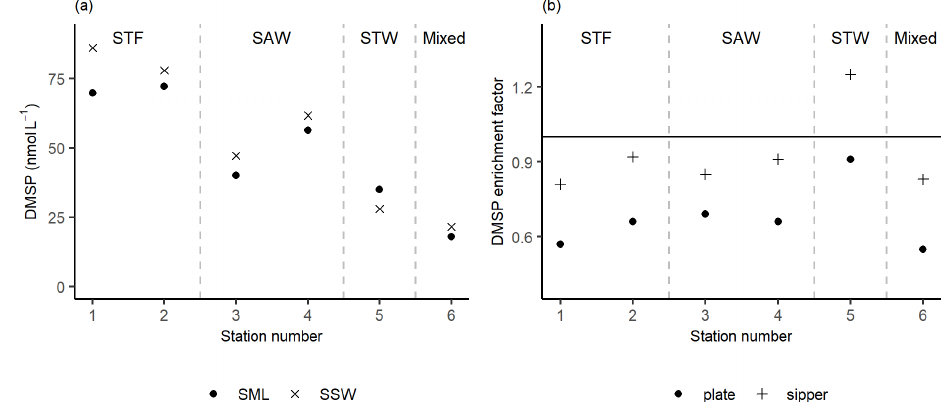
Figure 3. (a) DMSP concentrations sampled in the sea surface microlayer (SML) by the sipper and in the subsurface water (SSW) and the (b) DMSP enrichment factor from the sipper and plate. Water mass type is indicated by the labels at the top of the figure and separated by the grey vertical dashed